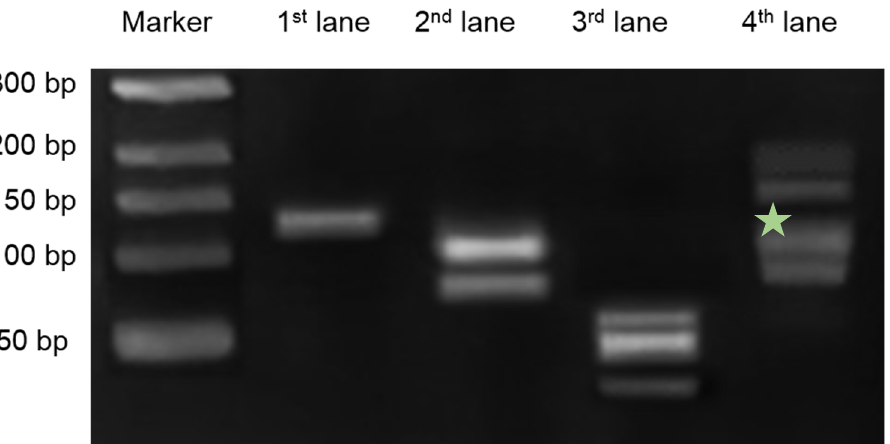
Figure 2. Results of gel electrophoresis of Walker DNA. Gel electrophoresis of DNA structures. Lane 1. locked Walker DNA; Lane 2. Unlocked Walker DNA and target DNA; Lane 3. separated attaching hairpin, detaching hairpin, and marker DNA; Lane 4. target DNA + locker DNA; walker DNA fully assembled DNA and target DNA. The green star denotes the position of Assembled DNA (attaching hairpin + detaching hairpin + marker DNA).